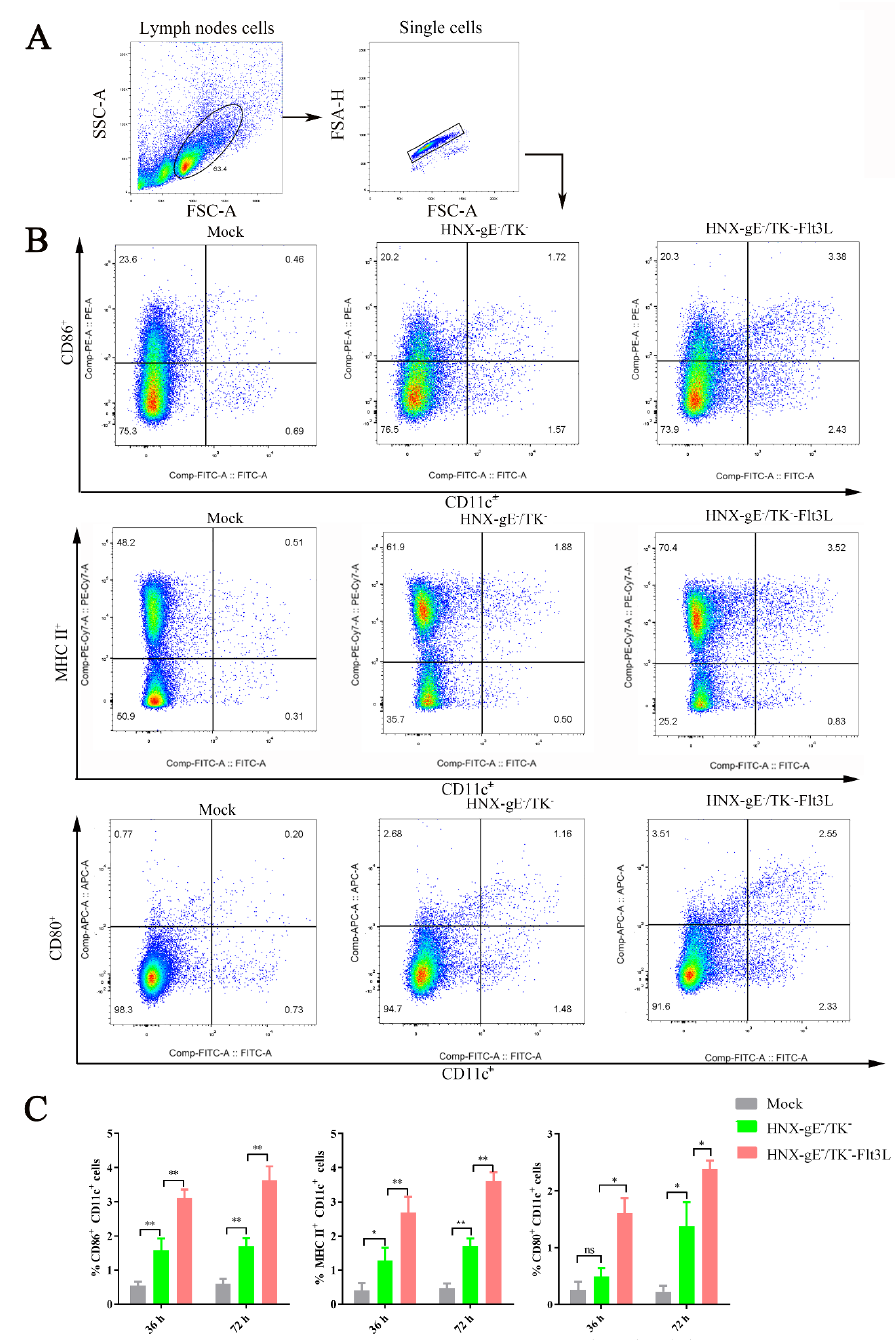
Figure 5. DC activation in mice immunized with HNX-TK − /gE − -Flt3L. BALB/c mice were immu- nized with 1 × 10 5 TCID 50 of HNX-TK − /gE − -Flt3L, HNX, or DMEM. The inguinal lymph nodes were collected at 36 and 72 hpi. Single cell suspensions prepared from the inguinal lymph nodes were analyzed for the presence of DCs. ( A ) Representative gating strategy for DCs. ( B ) Representative flow cytometric plots of activated DCs (CD11c+ CD86+ cells, CD11c+ MHCII+ cells, and CD11c+ CD80+ cells). ( C ) Percentages of activated DCs (CD11c + CD86 + cells, CD11c + MHCII + cells, and CD11c + CD80 + cells) are summarized statistically in the chart. The data are the means from three independent experiments (* p < 0.05; ** p <